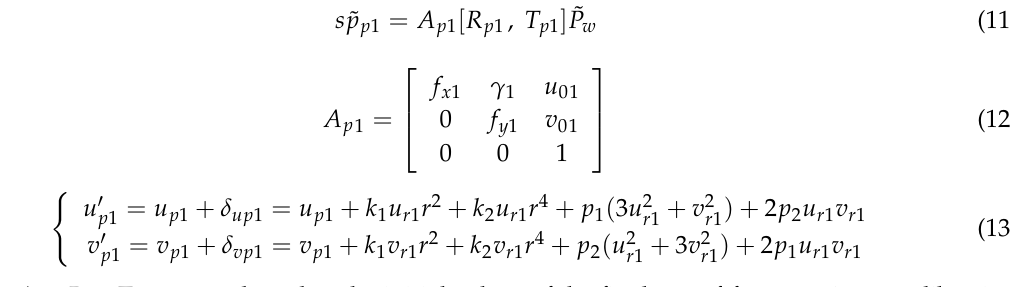
Figure 9. Model of an out-of-focus projector: ( a ) original model; and, ( b ) double the focal plane model.